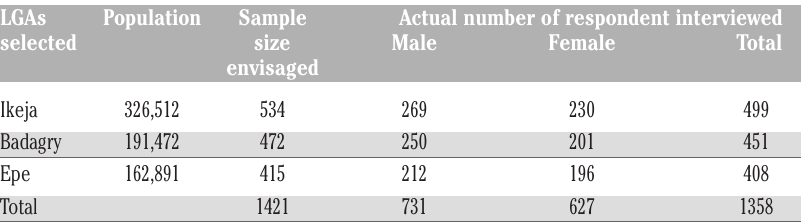
Table 1. Summary profile of sample size and actual number of